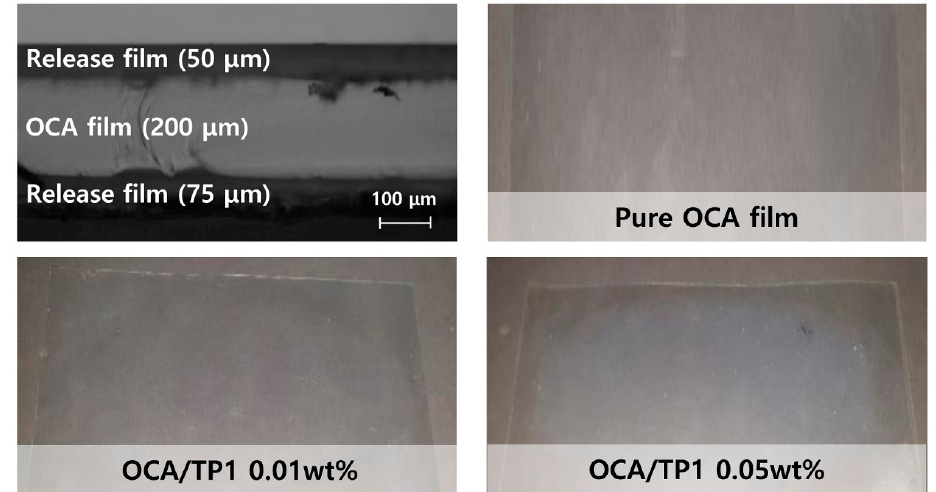
Figure 6. Optical microscopic and photographic images of the OCA films embedded with hybrid nanoparticles (TP1).